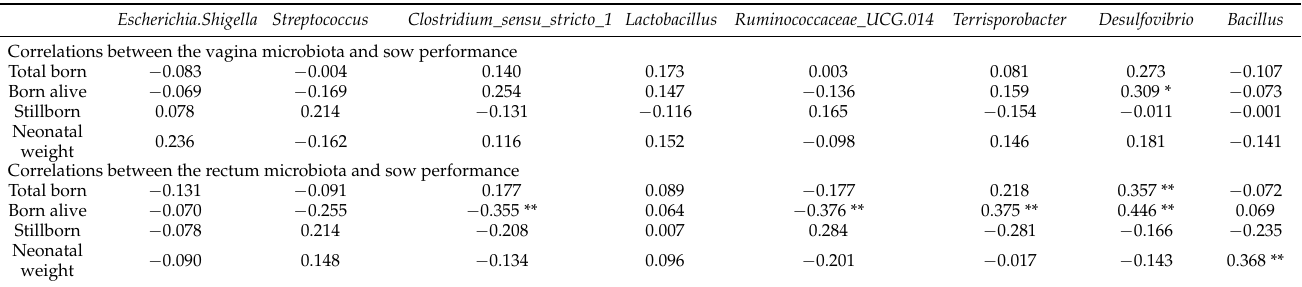
Table 4. Spearman correlations between the vagina or rectum microbiota at genus level and sow performance. Escherichia.Shigella